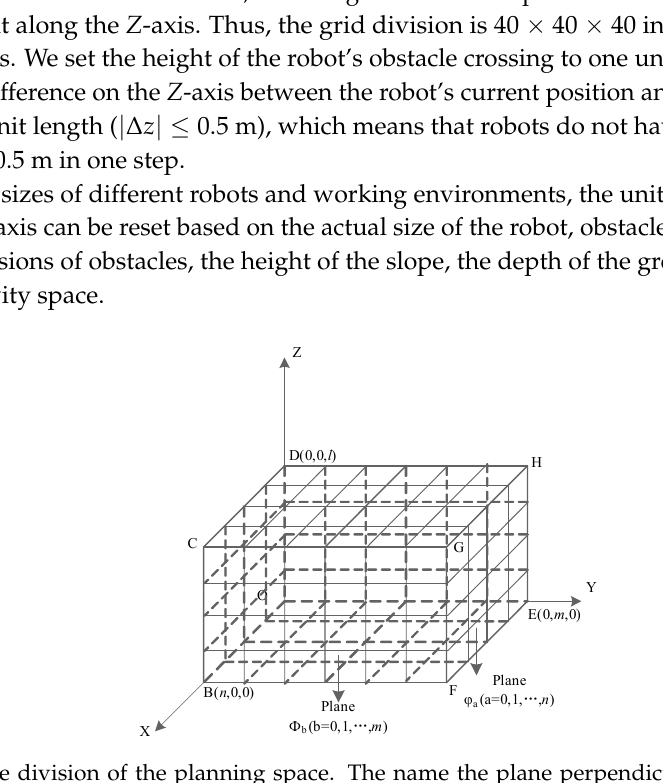
Figure 2. The division of the planning space. The name the plane perpendicular to the Y -axis in “Plane = Φ ( 0,1,..., ) b m ”, and the name of the plane perpendicular to the X -axis in “Plane b = ( 0,1,..., ) φ a n ”. a